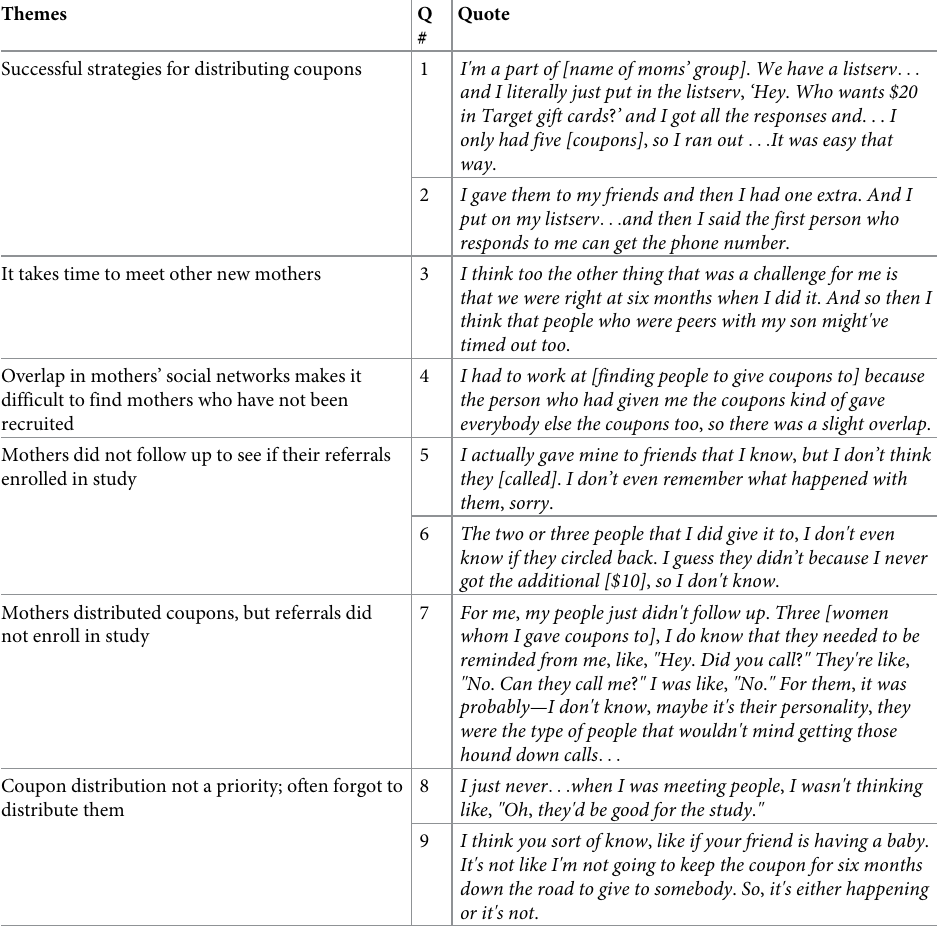
Table 2. Qualitative themes and representative quotes